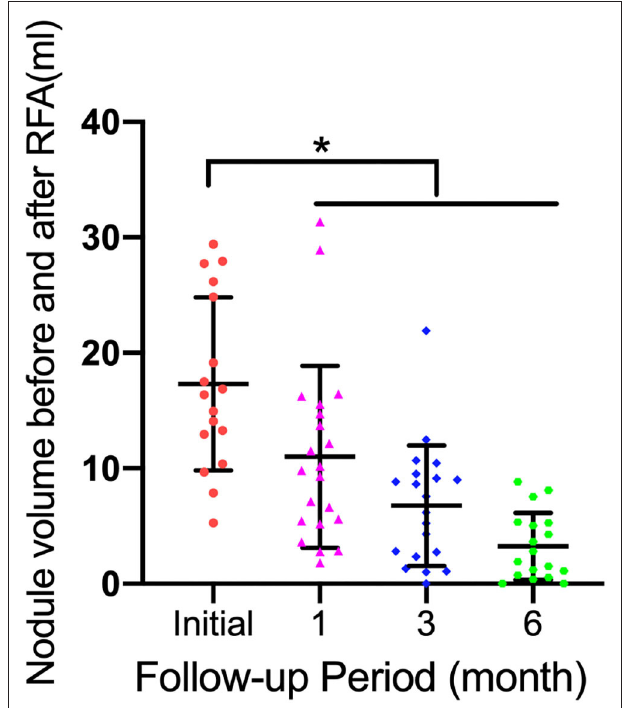
Figure 3 . The mean VRRs of all nodules were 60.86 ± 23.25%, 74.71 ± 16.57%, and 83.41 ± 13.96% at the 1, 3, and 6 month follow-ups, respectively ( p < 0.05) ( Figure 3 ).